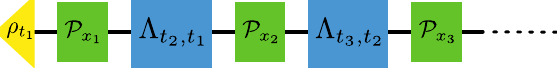
that do not t j þ 1 ;t j (depicted in t 1